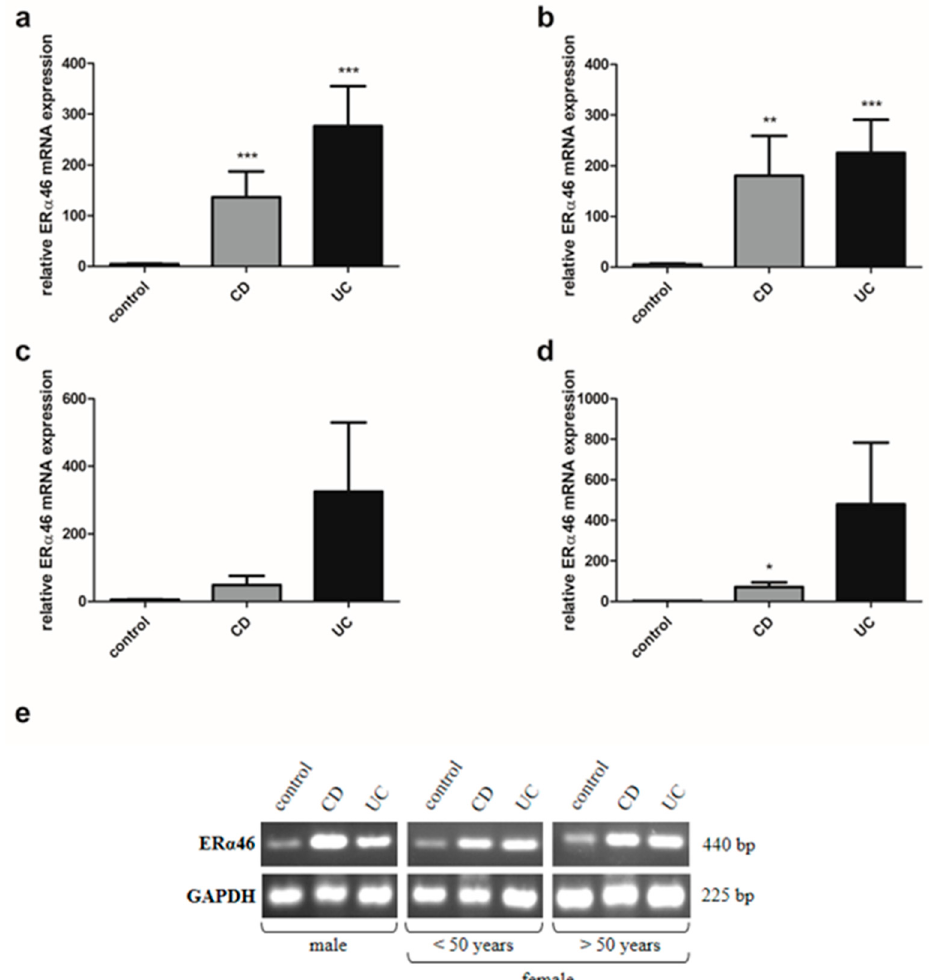
Figure 8. Expression of ER α 46 at mRNA level in CD and UC patients and the control group regardless of sex and age ( a ; control, n = 31; CD, n = 31; UC, n = 42), male with CD and UC ( b ; control, n = 12; CD, n = 19; UC, n = 24), females with CD an UC under the age of 50 years ( c ; control, n = 9; CD, n = 7; UC, n = 12), females with CD and UC over the age of 50 years and related controls ( d ; control, n = 10; CD, n = 5; UC, n = 6). Representative agarose gel image of ER α 46 expression ( e ). Values are means ± SEM; * P < 0.05, ** P < 0.01, *** P < 0.001 vs. control.